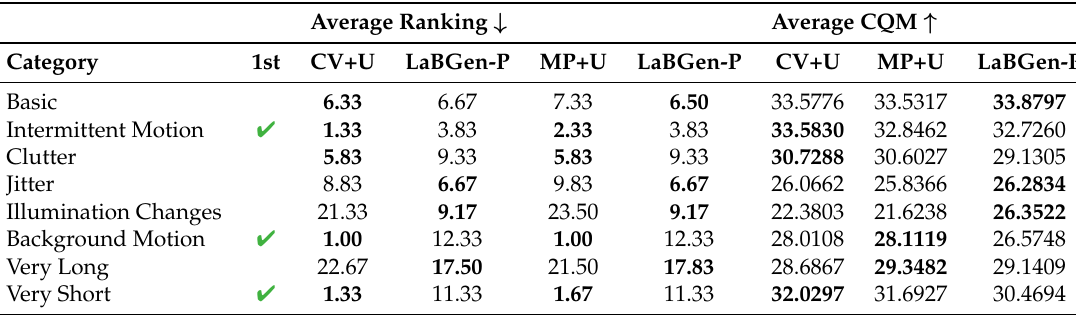
Table 6. Average ranking and CQM per category, reported on the SBMnet website, of LaBGen-P and LaBGen-P-Semantic with CV+U and MP+U. The best ranks and scores are indicated in bold, and the categories in which LaBGen-P-Semantic is ranked first on the SBMnet website are indicated in column “1st”. The results were submitted 6 May